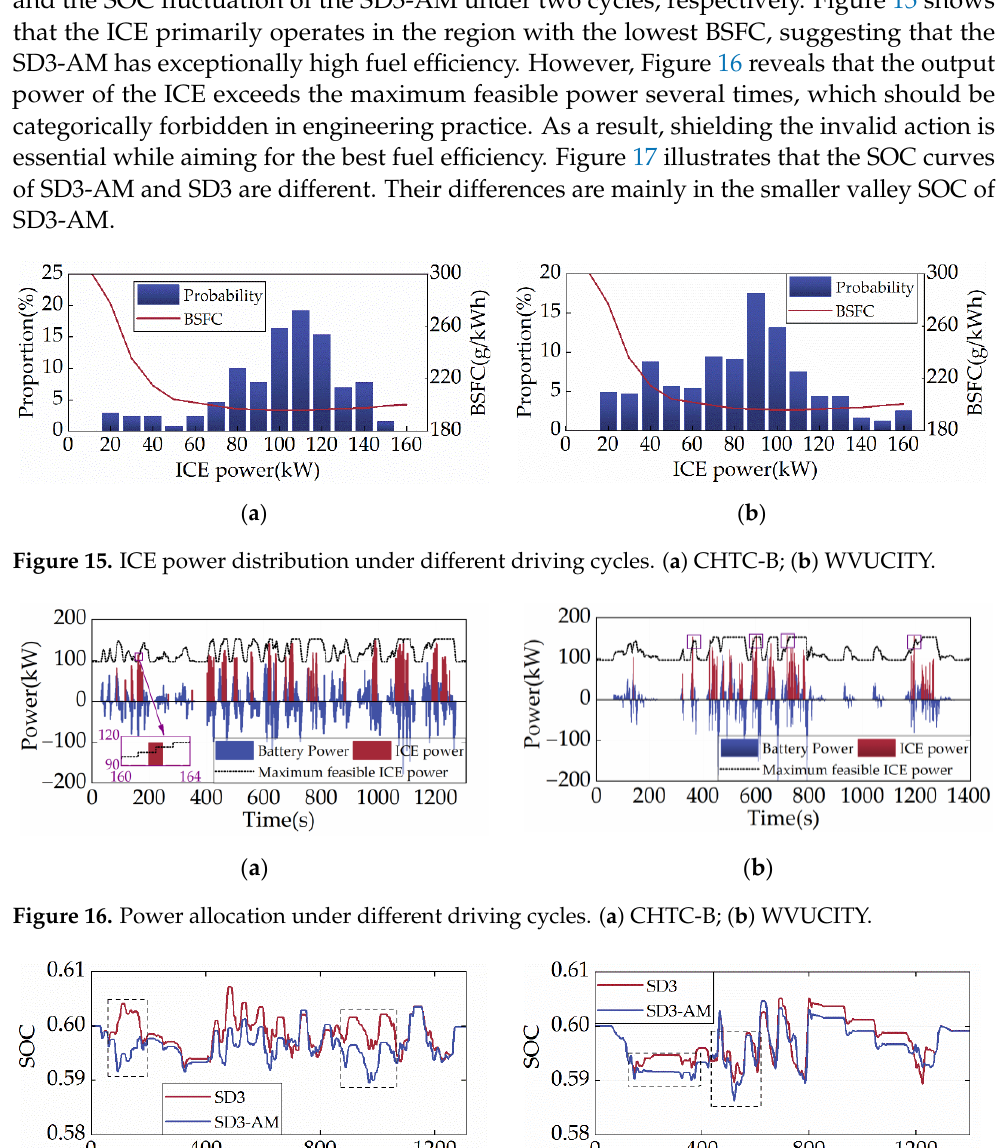
Figure 14. The number of invalid actions. ( a ) CHTC-B; ( b ) WVUCITY.